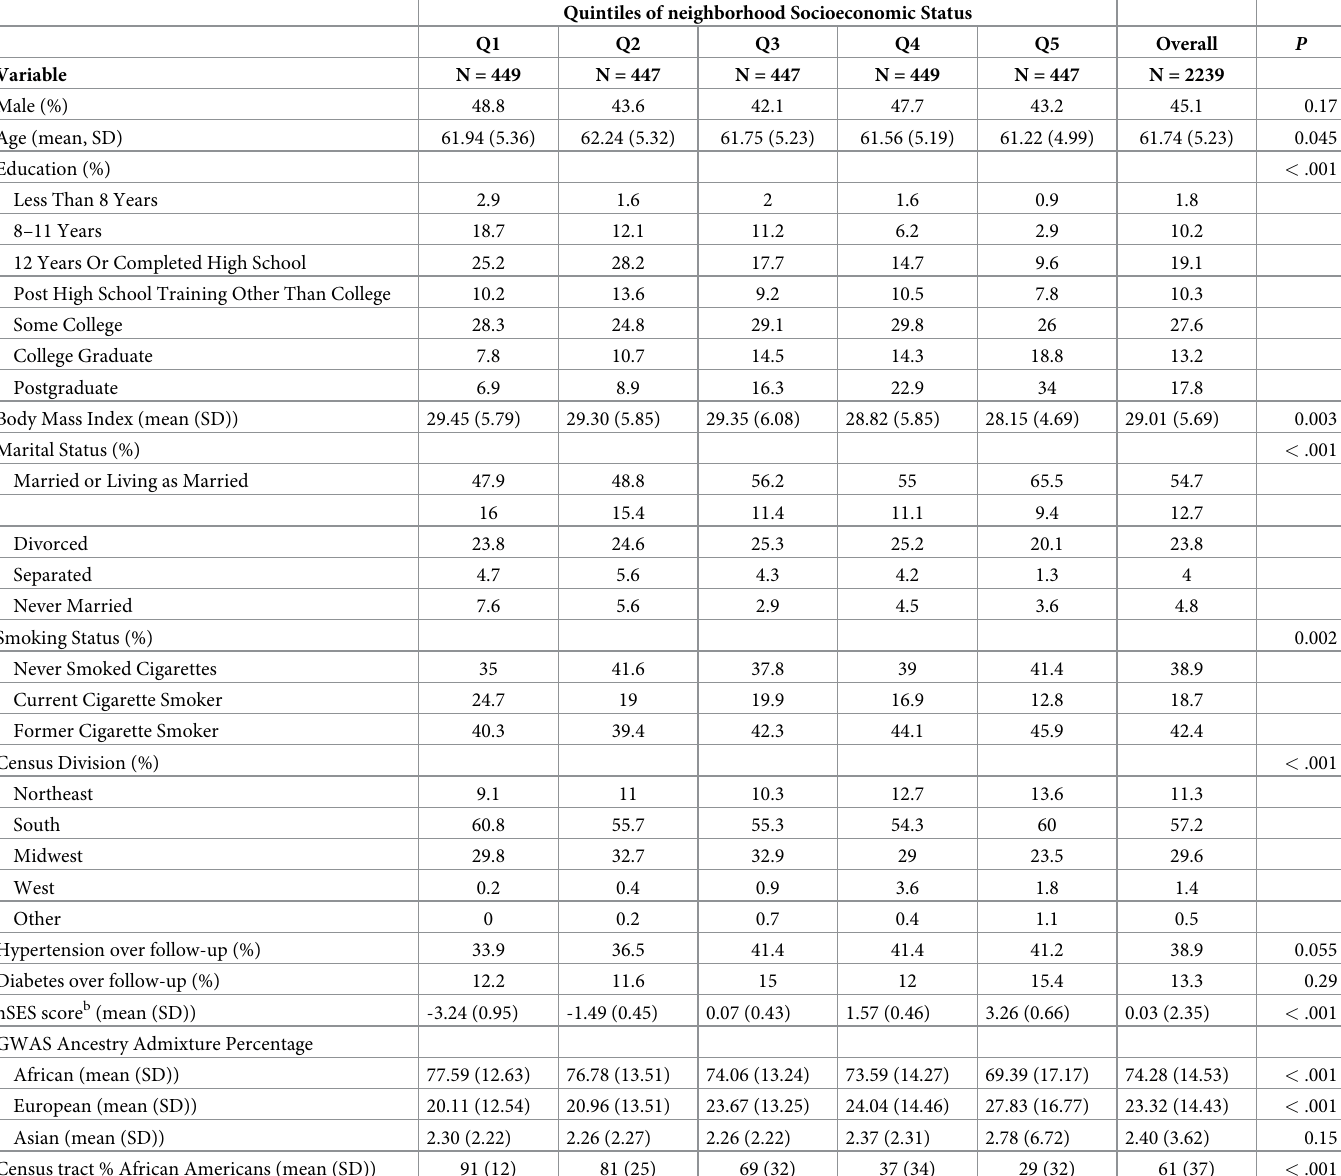
Table 1. Baseline descriptive characteristics of self-identified African American men and women Participating in the prostate, lung, colorectal, and ovarian cancer screening trial by quintiles of neighborhood socioeconomic status, United States, 1993 a